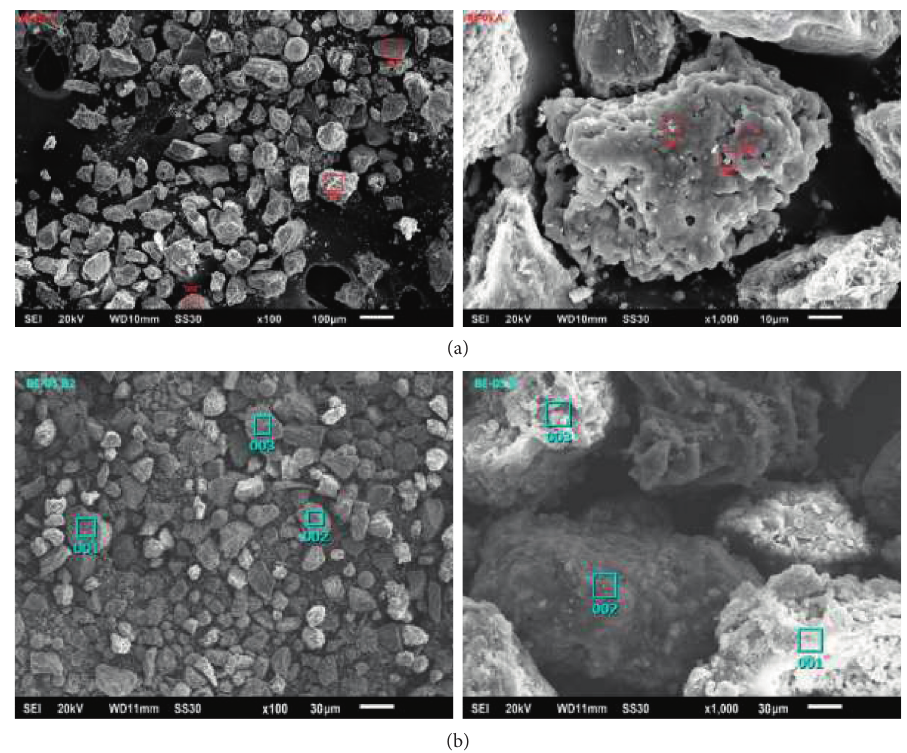
Figure 4: Comparison of 100x and 1,000x magnification of BD-2A at (a) 550 ° C and (b) 600 °